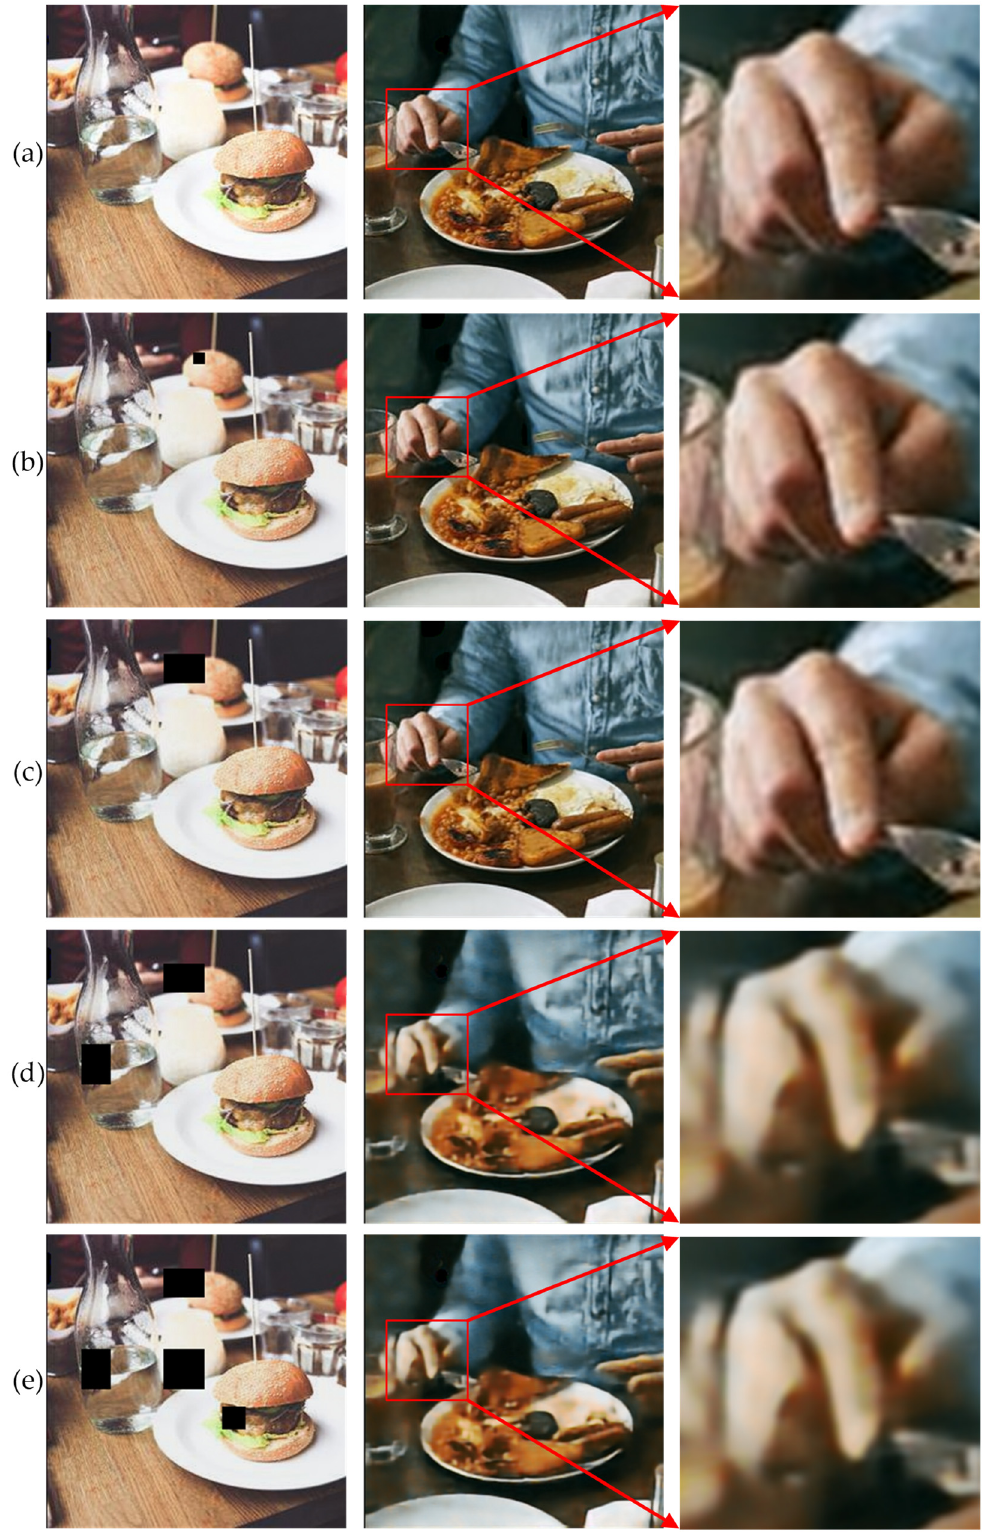
Figure 12. Comparison of reconstructed secret images from containers cropped at different sizes (the black areas indicate the cropped area): ( a ) no cropping, ( b ) 10 × 10, ( c ) 25 × 30, ( d ) two of 25 × 30, and ( e ) three of 25 × 30. From left to right correspond to cropped containers, reconstructed secret images, and magnified hand areas in the reconstructed secret images, respectively.